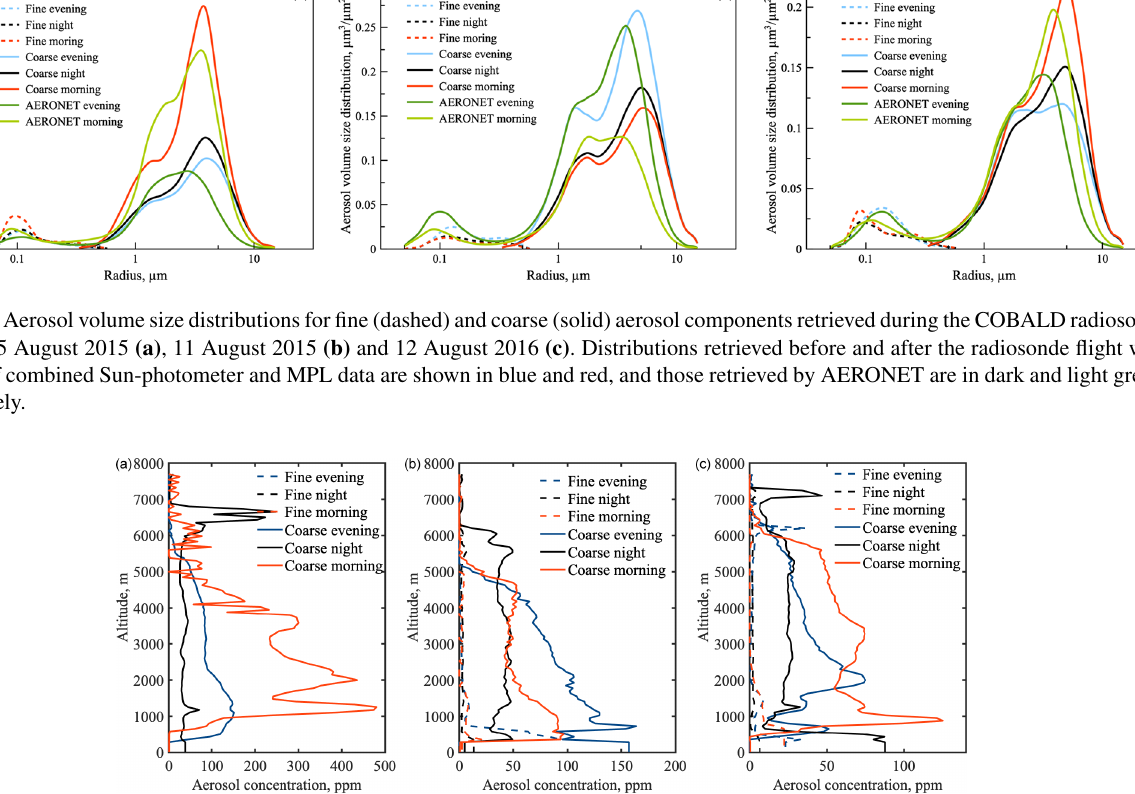
Figure 5. Aerosol vertical distributions for fine (dashed) and coarse (solid) aerosol components retrieved during the COBALD radiosonde flight (black) on 5 August 2015 (a) , 11 August 2015 (b) and 12 August 2016 (c) . Distributions retrieved before and after the radiosonde flight with the use of MPL data are shown in blue and red,